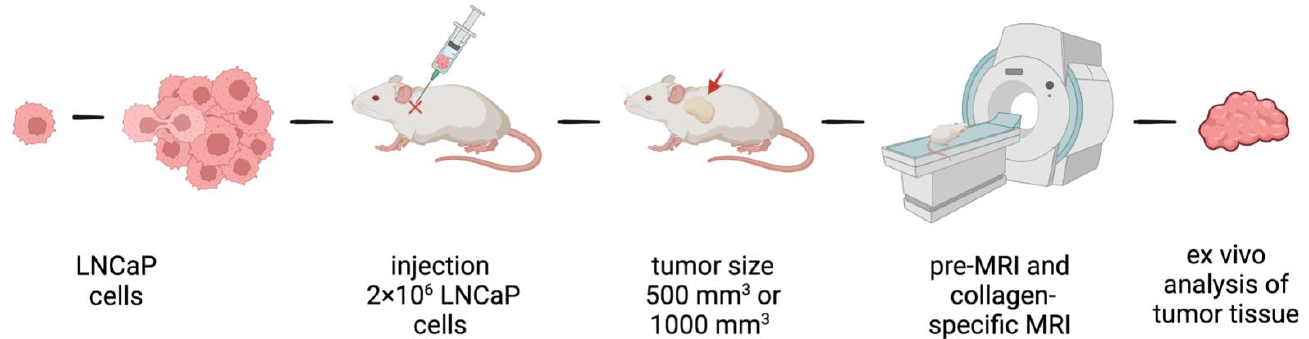
Figure 1. Study design. LNCaP tumor cells were injected subcutaneously into the mouse near the right scapula. After reaching the desired tumor size, a pre-contrast MR image of the tumor was taken, and then the collagen-specific contrast agent was injected intravenously via the tail vein. After the MRI examination, the mouse was euthanized, and the tumor was used for ex vivo experi- ments.